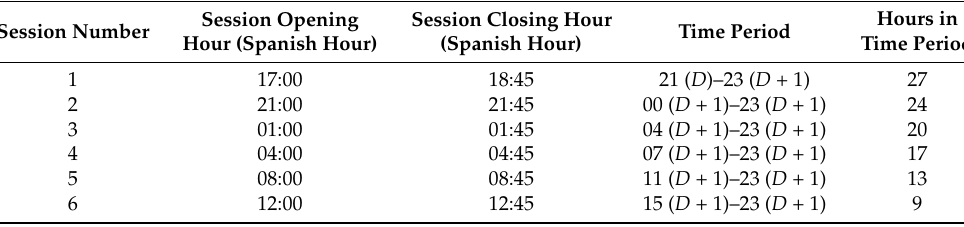
Table 1. Structure of the Iberian electricity market’s (MIBEL’s) intraday sessions.